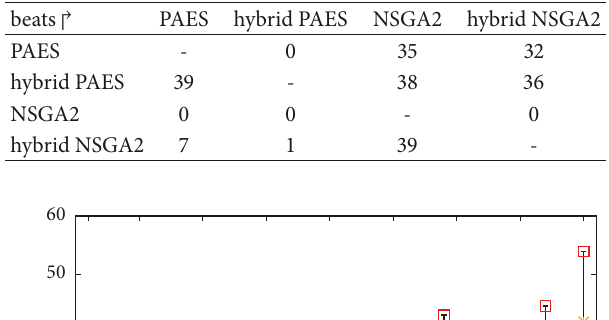
Table 2: Number of test-cases, over the 40 test-cases of the Beasley benchmark, for which the Kruskal-Wallis nonparametric test vali- dates the hypothesis that EMOAs beat each other for hypervolume.